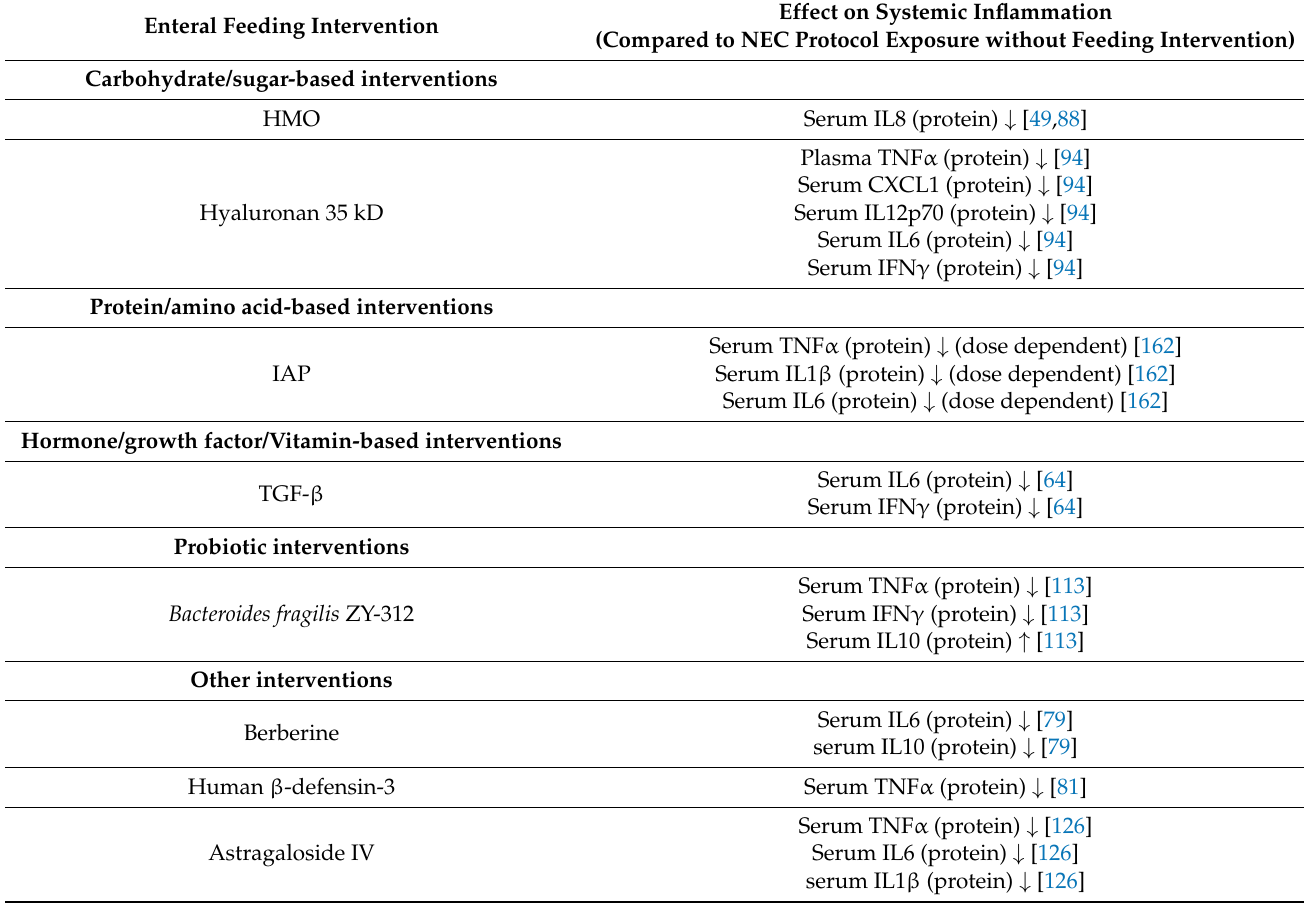
Table 7. Effect of enteral feeding interventions that reduce systemic inflammation in experimental animal models of NEC. Effect on Systemic Inflammation Enteral Feeding Intervention (Compared to NEC Protocol Exposure without Feeding Intervention) Carbohydrate/sugar-based